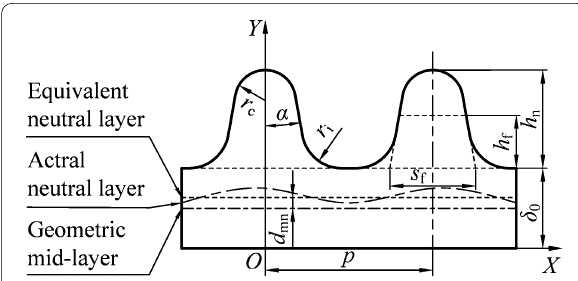
Figure 9 Schematic diagram of rack structure and equivalent neutral layer